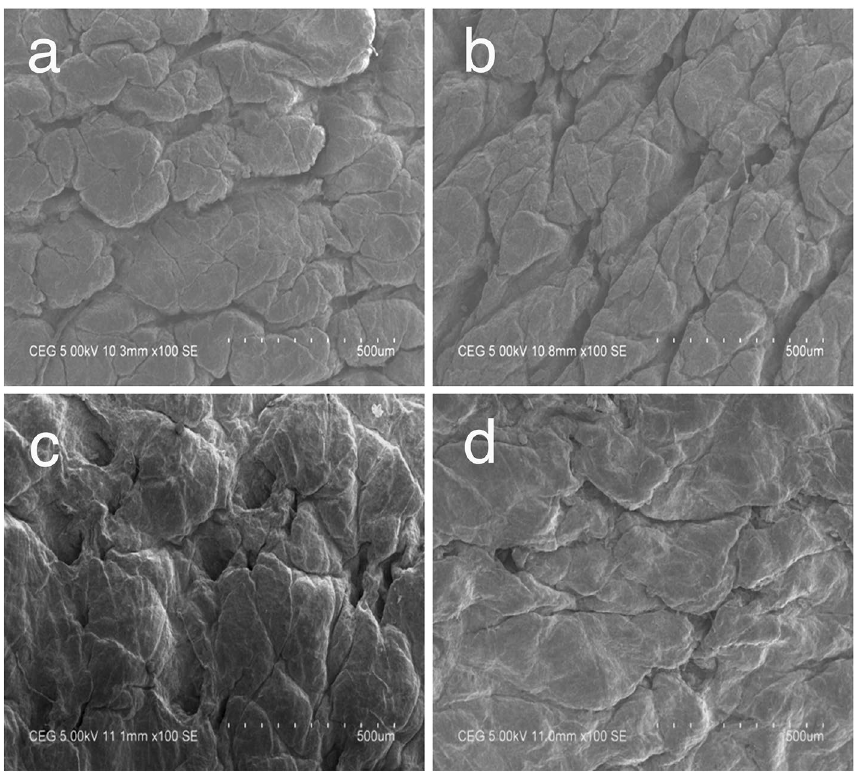
Figure 6. Scanning electron micrographs of grain surface of control and experimental leathers at 100× magnification ( a ) Control (water), ( b ) Heptane, ( c ) Propylene glycol and ( d ) PEG 200.